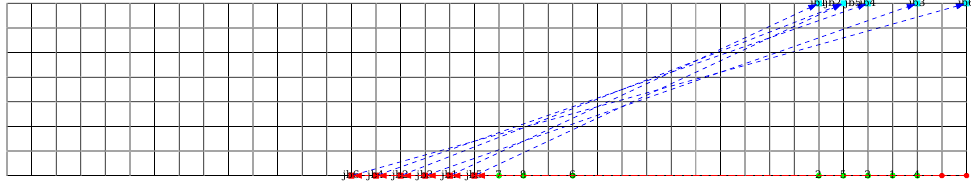
Figure 7. The crafted problem instance that is difficult for the strict move corridor definition. The densely connected grid structure, meant that the strict corridor definition, which requires that corridor vertices be no further from the goal vertex than a shortest path vertex, failed to define an adequate corridor beyond the shortest paths themselves.